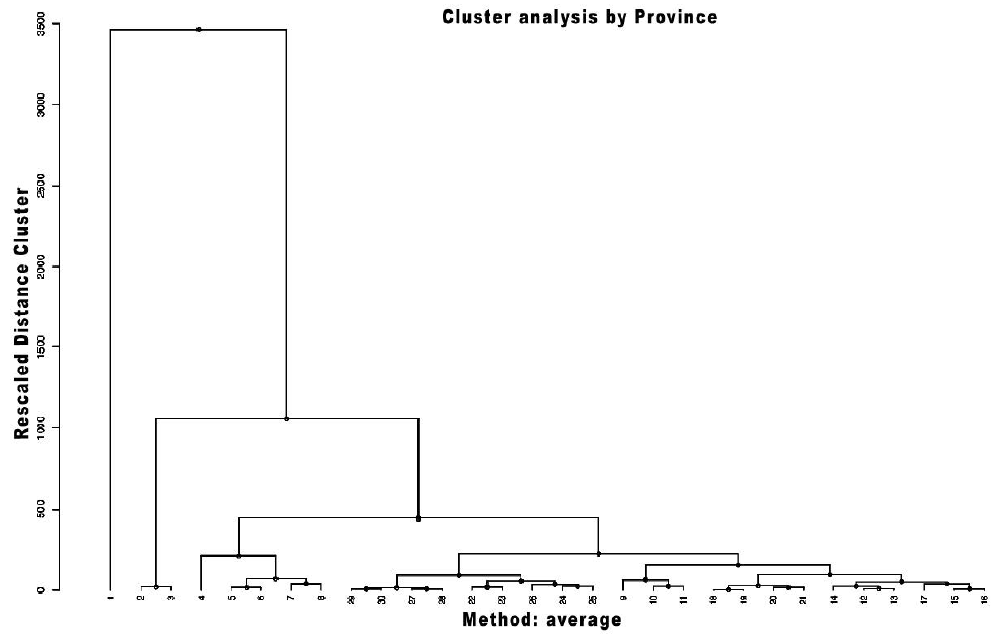
Figure 1. Cluster analysis of population density and Covid-19 cases for China’s administrative regions.